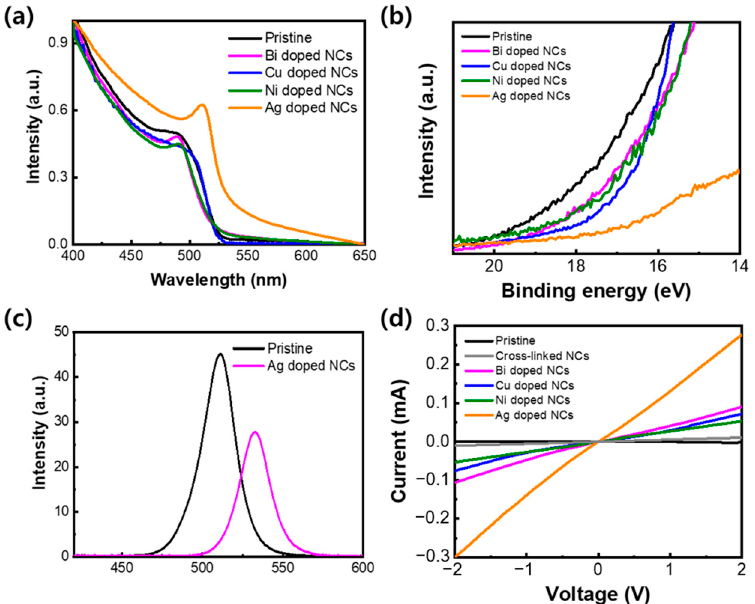
Figure 7. ( a ) UV–Vis spectra and ( b ) ultraviolet photoelectron spectroscopy of five different Perovskite NCs. ( c ) PL spectra of pristine NCs and Ag-doped NCs. ( d ) I-V curve of M-I-M structured devices using 6 different perovskite NCs as an insulating layer.